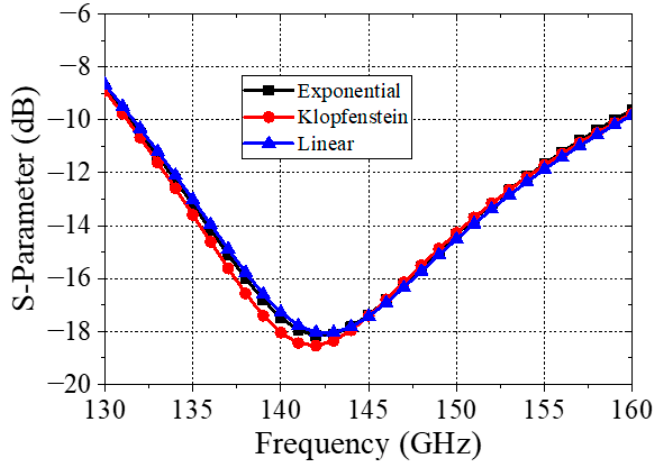
Figure 12. Comparison of performance of three different coplanar waveguide to microstrip transitions.